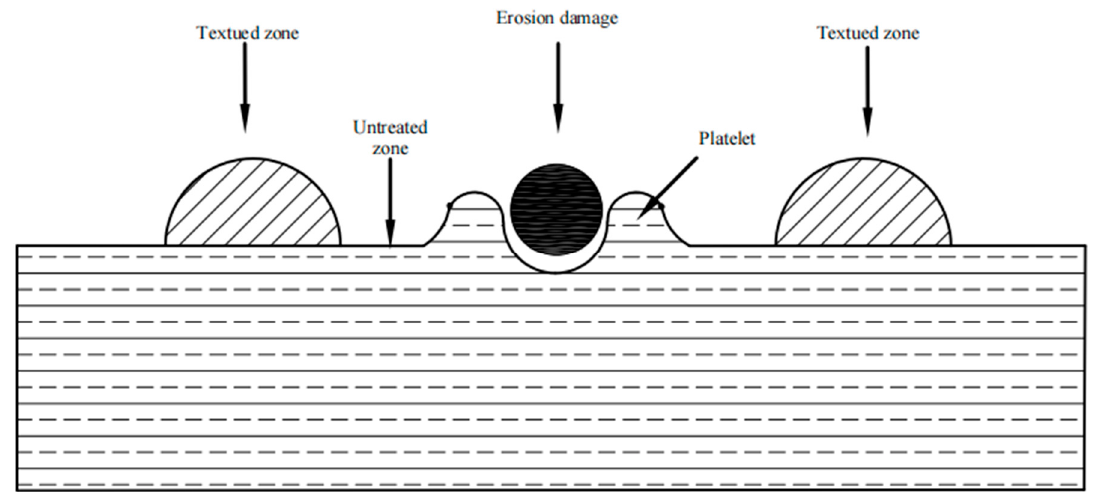
Figure 11. Schematic for underlying mechanism of the improvement for the erosion resistance of laser textured superhy- drophobic surface.